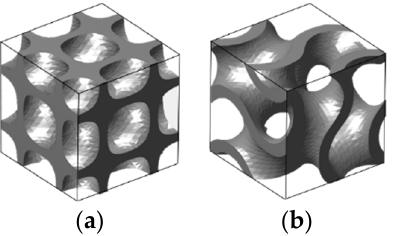
Figure 4. A single unit cell of ( a ) diamond-sheet structure; ( b ) gyroid-sheet structure for fulfilling the